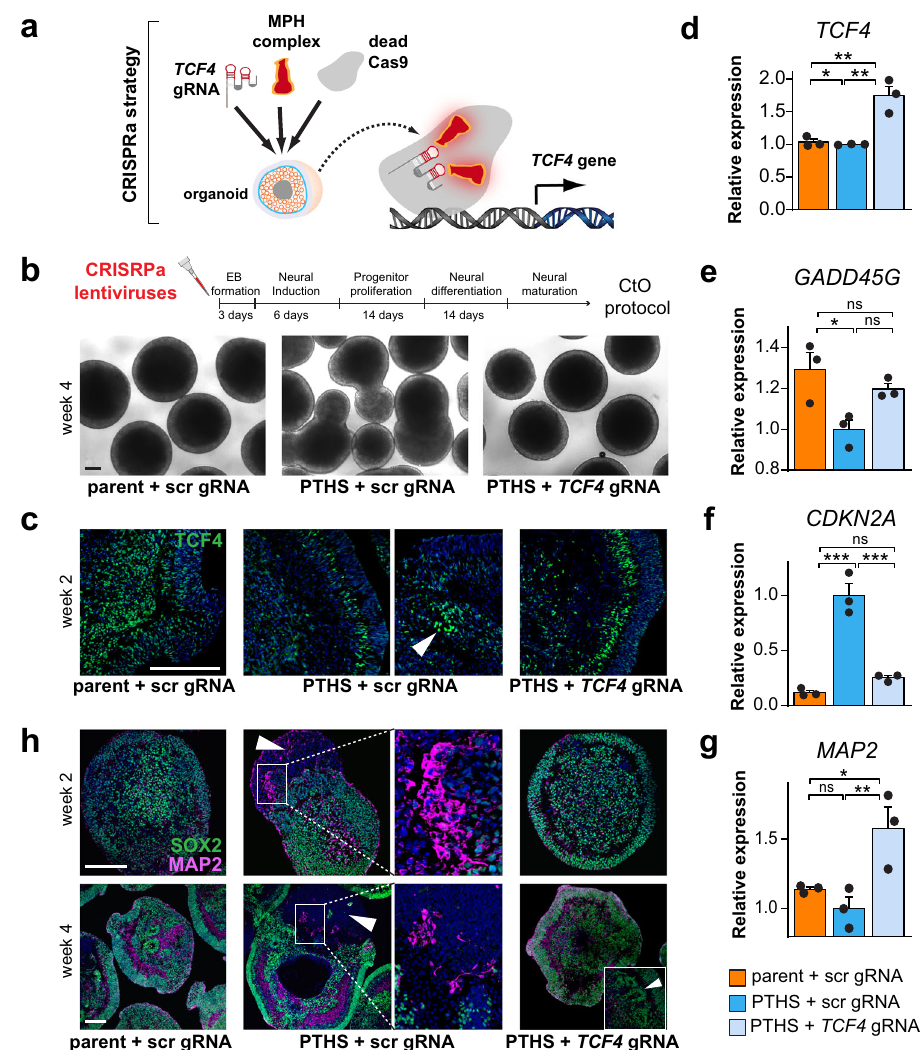
Fig. 8 Reversal of abnormal phenotypes in PTHS organoids after trans-epigenetic correction of TCF4 expression. a Schematic representation of CRISPR-based trans-epigenetic correction of TCF4 expression using constructs for guide RNA (gRNA), transcriptional activation module MPH, and dead Cas9 (see “ Methods ” for details). b Top: Virus application regimen. Bottom: Bright fi eld images of PTHS brain organoids at 4 weeks in vitro after correction of TCF4 expression (PTHS + TCF4 gRNA), compared with controls transduced with scrambled gRNA (scr gRNA). c Fluorescence microscopy images of transduced organoids at 2 weeks in vitro after immunostaining for TCF4 (green). Clustered TCF4 + cells (arrowhead) can be seen in aberrant outgrowth in image on the right in PTHS + scr gRNA condition. See Supplementary Fig. 12d, e for quanti fi cation of number of TCF4 + cells and mean TCF4 staining pixel intensity in transduced organoids. d Increase in TCF4 expression levels after CRISPR-mediated trans-epigenetic TCF4 correction in organoids at 2 weeks in vitro. N = 3 replicates per group (circles). e – g Expression levels of GADD45G ( e ), CDKN2A ( f ), and MAP2 ( g ) in organoids at 4 weeks in vitro after trans- epigenetic TCF4 expression correction. N = 3 replicates per group (circles). Organoids are from parent – patient pair #4. h Transduced organoids stained for MAP2 (magenta) and SOX2 (green), at two developmental time points. Arrowheads in middle panels: polarized PTHS organoids. High mag insets: clustered abnormally shaped MAP2 + cells in polarized organoid outgrowth. Arrowhead in right panel: neural rosettes. Experiments were conducted with organoids from parent-patient pair #4 (circle symbols in bar graphs). Colors in bar graphs represent parents (orange), PTHS (blue), or genetically manipulated PTHS (light blue) groups. Error bars represent SEM. n.s., not signi fi cant; * p < 0.05; ** p < 0.01; *** p < 0.001; one-way ANOVA followed by Tukey ’ s HSD post-hoc test in bar plots. Scale bars are 100 μ m. DAPI nuclear staining in blue. See Supplementary Data 1 for sample and effect sizes and exact p -values. Attribution of DNA image in a : Ioana mean fi ring rate and number of network electrical bursts (Fig. 9d and Supplementary Fig. 13d).